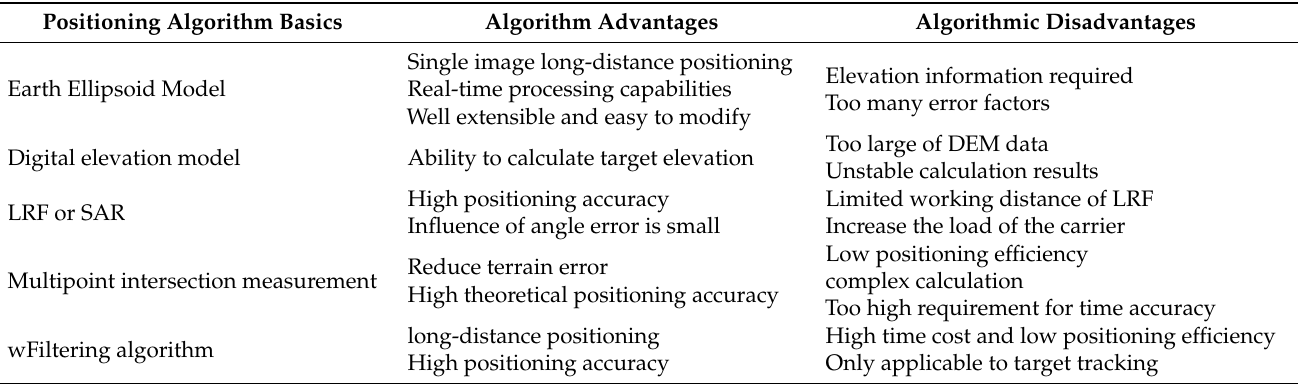
Table 1. Summary table of typical target localization algorithms. Positioning Algorithm Basics Algorithm